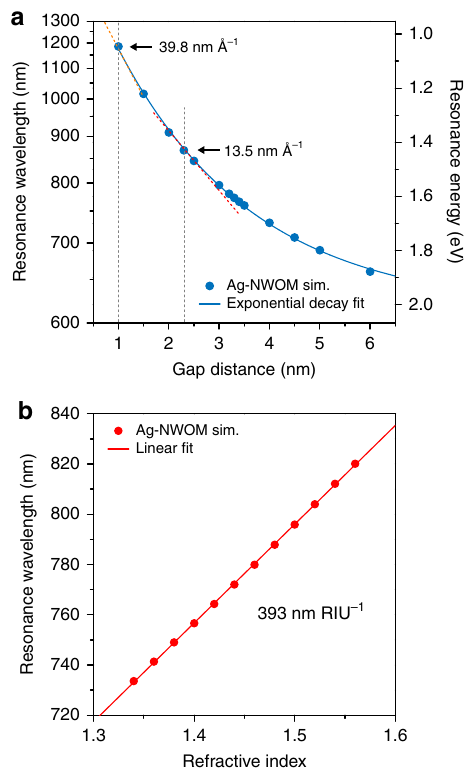
Fig. 4 Simulations of the thermal-expansion-induced spectral shift. a Peak position of a 70-nm-diameter PVP-coated Ag-NWOM as a function of the thickness of the PVP coating. The vertical differential sensitivity with a 2.3- and a 1-nm-thick PVP layer is 13.5 and 39.8 nm Å − 1 , respectively. b Peak position of a 2.3-nm-thick dielectric layer-coated 70-nm-diameter Ag- NWOM as a function of the RI of the dielectric